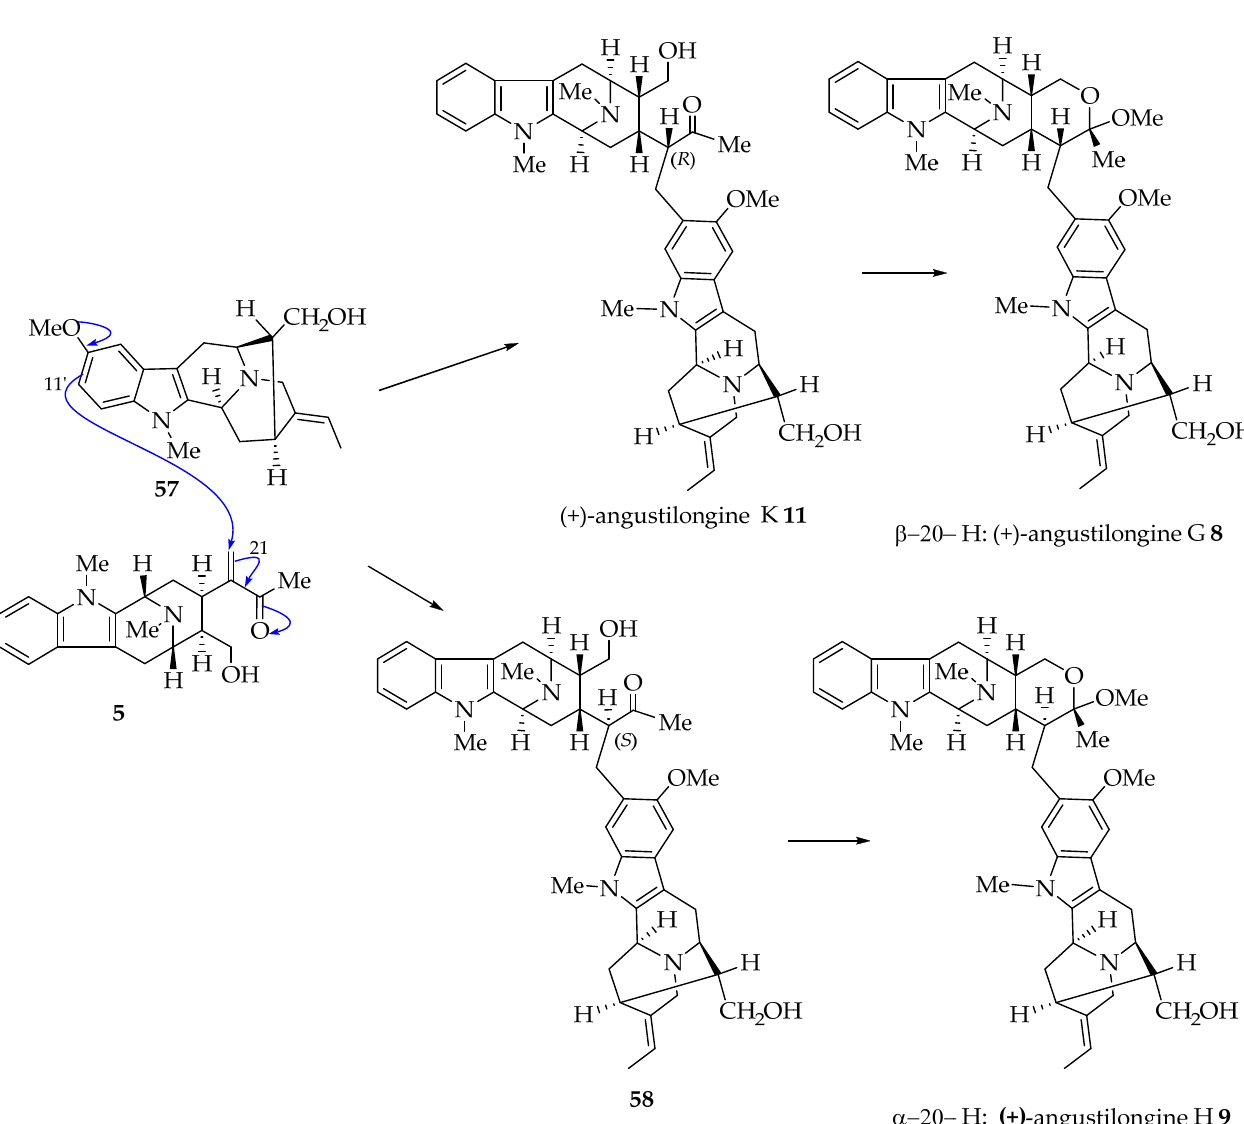
Figure 1. Proposed biogenetic pathway to (+)-angustilongine G 8 and (+)-angustilongine H 9. 4.4. Possible Alternative Mechanism of Bisindole Formation of (+)-Lumutinine A 16 and (+)-Macralstonine 24 as Representative Examples via a Friedel–Crafts Alkylation Process as Suggested by